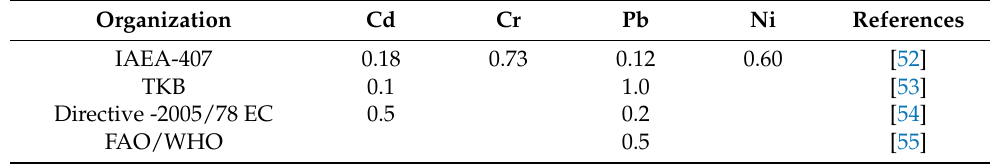
Table A1. The tolerable values of some toxic trace elements in the fish (mg/kg).